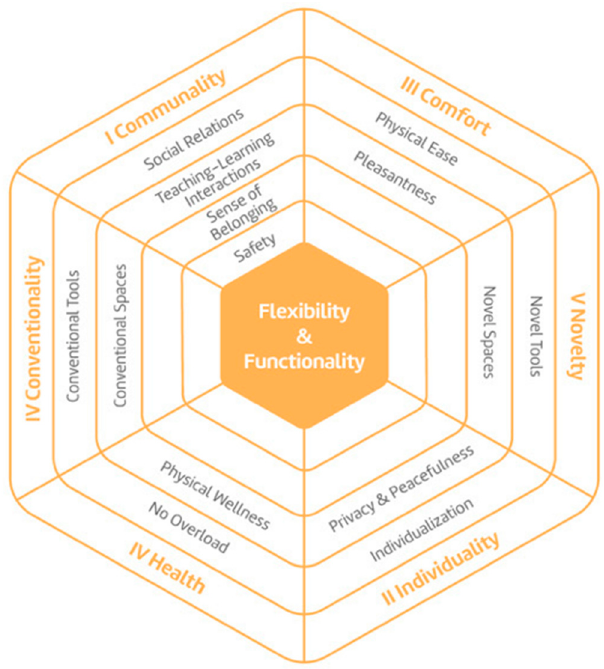
Figure 5. Visualisation of the LED framework V3 by Iconograph [100].